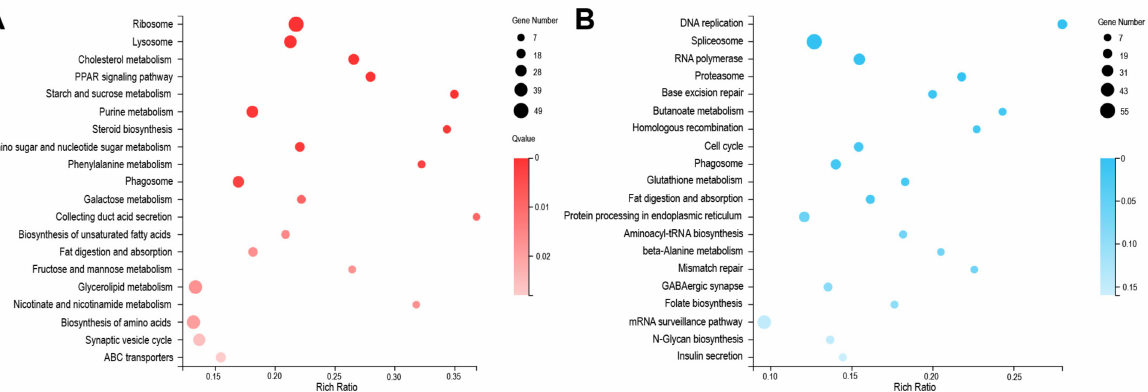
Figure 6. KEGG pathways of DEGs between WT and KO-METTL4 mutant. Signal pathway enrich- ments of DEGs were analyzed by Kyoto Encyclopedia of Genes and Genomes (KEGG). The images exhibited top 20 statistics of up-DEGs ( A ) and down-DEGs ( B ) on KEGG